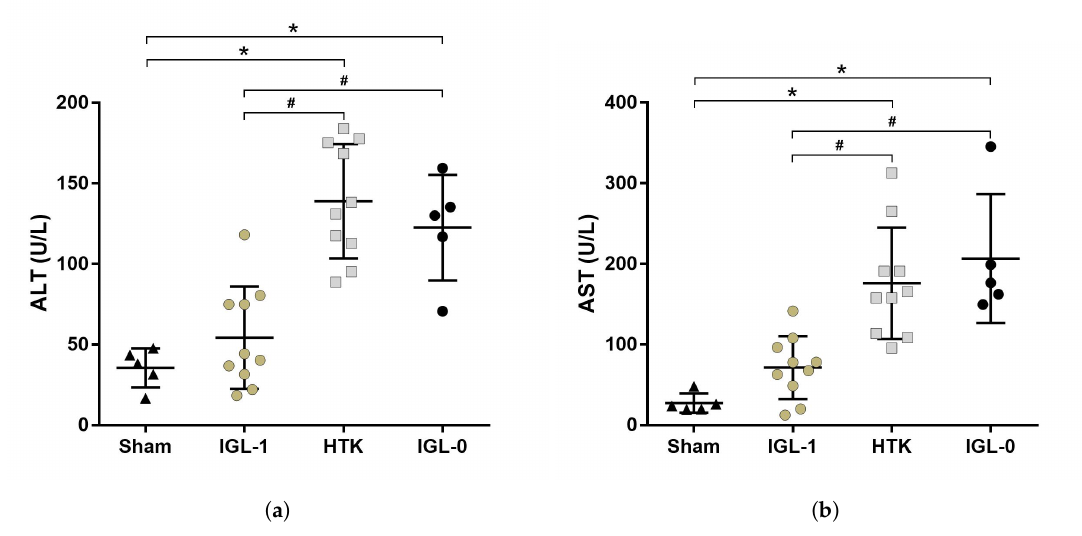
Figure 1. Fatty liver ischemia injury. Transaminases were collected after procurement (Sham group) or after 24 h of cold preservation in IGL-1, HTK or IGL-0 solutions (IGL-1, HTK and IGL-0 group, respectively). Transaminases ALT ( a ) and AST ( b ) release were higher in the HTK group compared to the three groups and IGL-0 transaminases were higher than Sham and IGL-1 groups. Results are presented as mean (SD), IGL-1/HTK n = 10/group, Sham/IGL-0 n = 5/group, * p < 0.05 vs. Sham; # p < 0.05 vs. IGL-1 (One-way